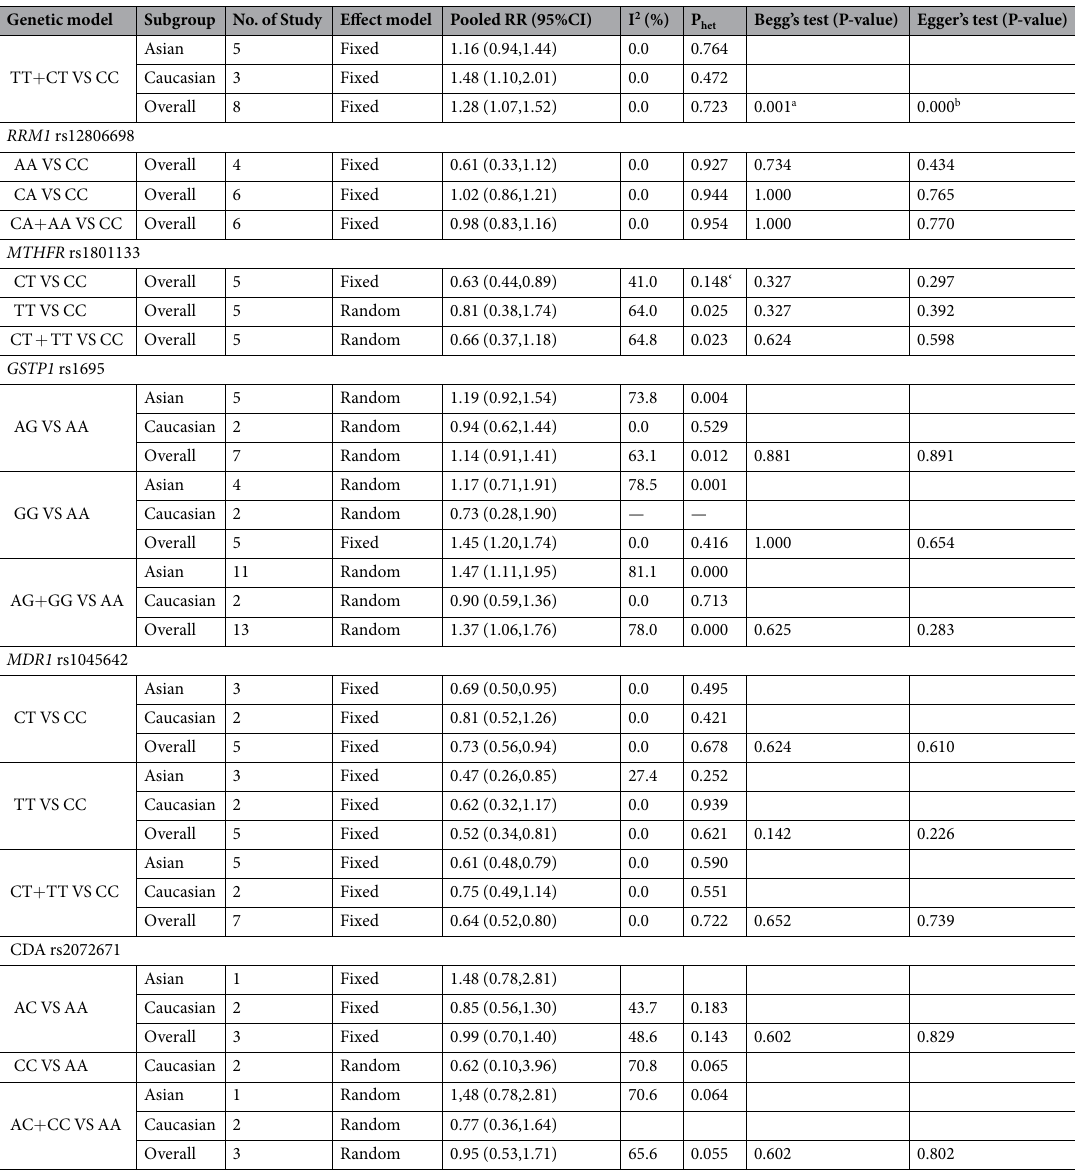
Table 2. The association between candidate gene polymorphisms and objective response. a Begg’s test P < 0.05; b Egger’s test P < 0.05. X-Ray Cross-Complementing Group 3 (XRCC3). Results from subgroup meta-analysis sorted by ethnicity showed that T allele of XRCC1 rs861539 (C241T) was associated with the positive response of PBC treatment in Caucasian population, three genetic models had consistent results (CT VS CC: RR = 1.46, 95% CI =